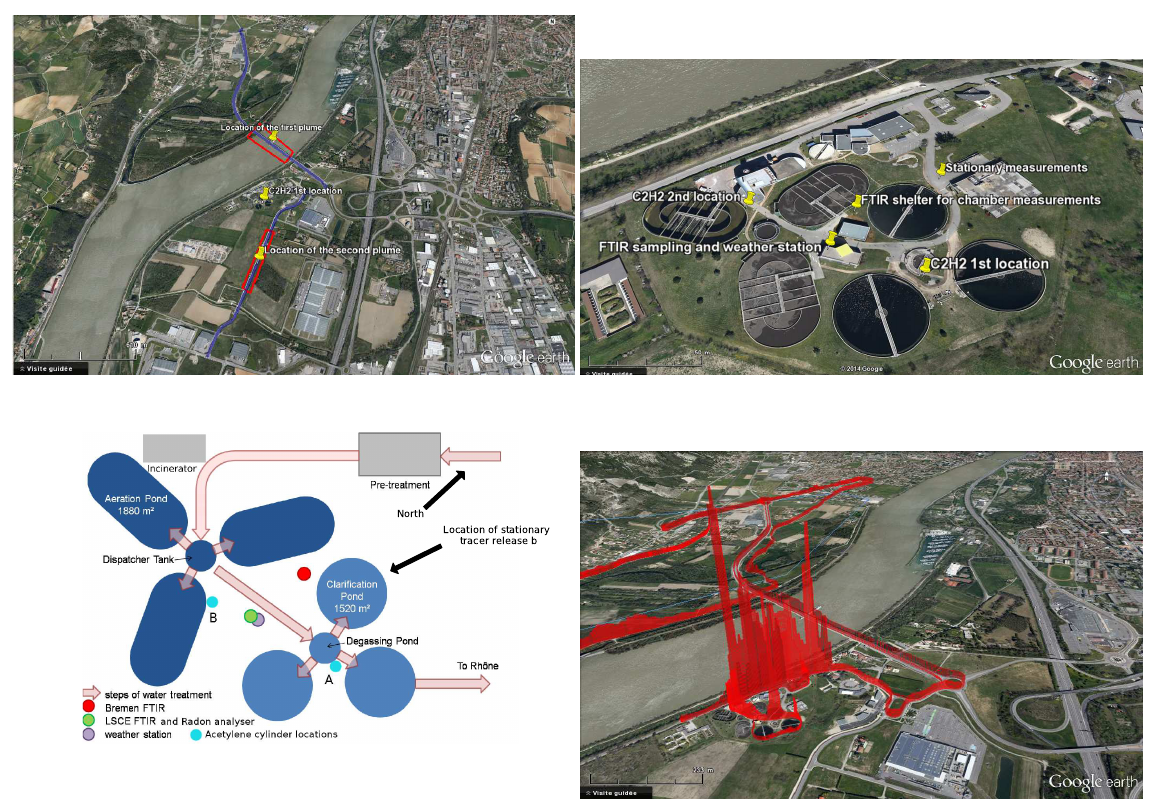
Figure 1. (a and b) Aerial view (Google Earth) of the WWTP. The blue lines show the driving paths during the tracer release experiment and the red rectangles show the location of the plumes. (c) Schematic view of the waste water treatment plant. (d) Aerial view of the WWTP with methane concentrations shown as red rectangles measured on 18 September with a northeast wind. The signals showed are above 1850ppb. The highest signal near the incinerator is